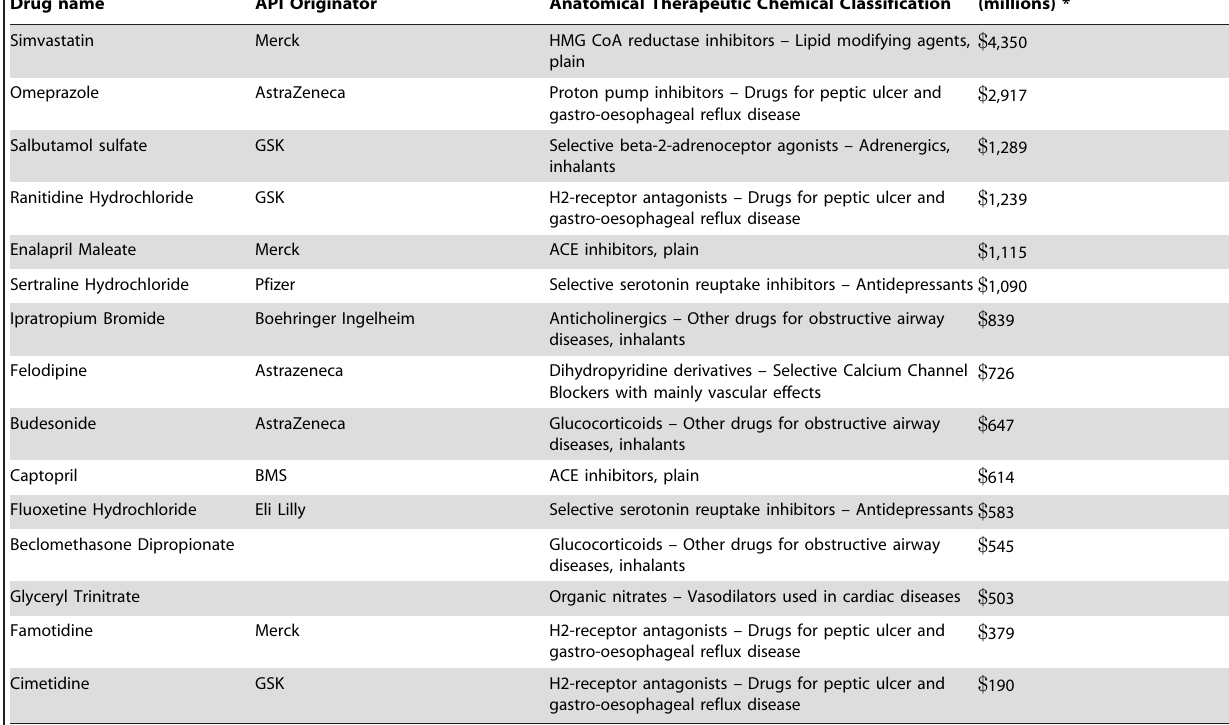
Table 1. Study sample of high-cost